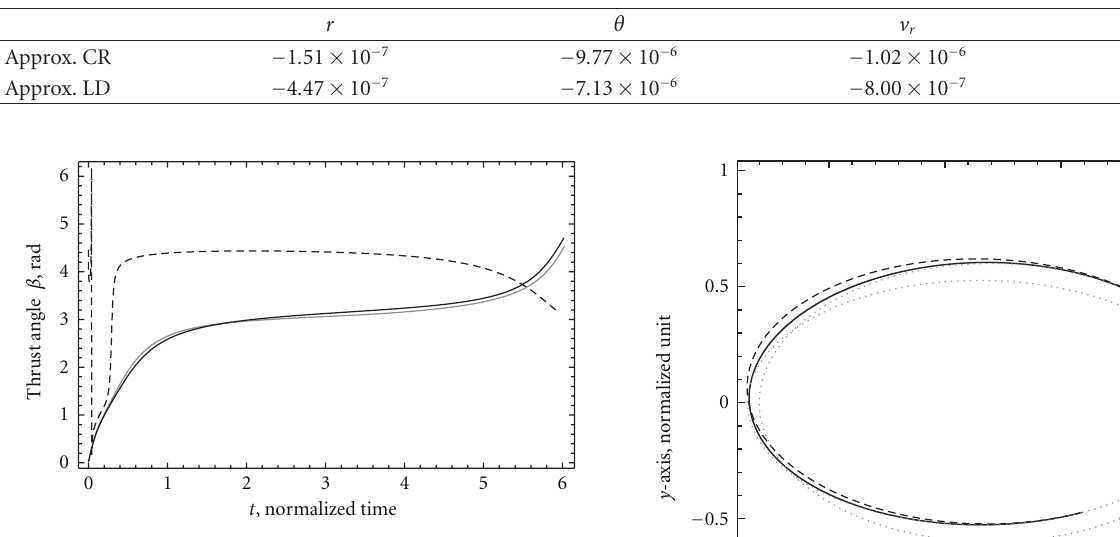
Figure 2: Thrust angle comparison of di ff erent trajectories in case B.